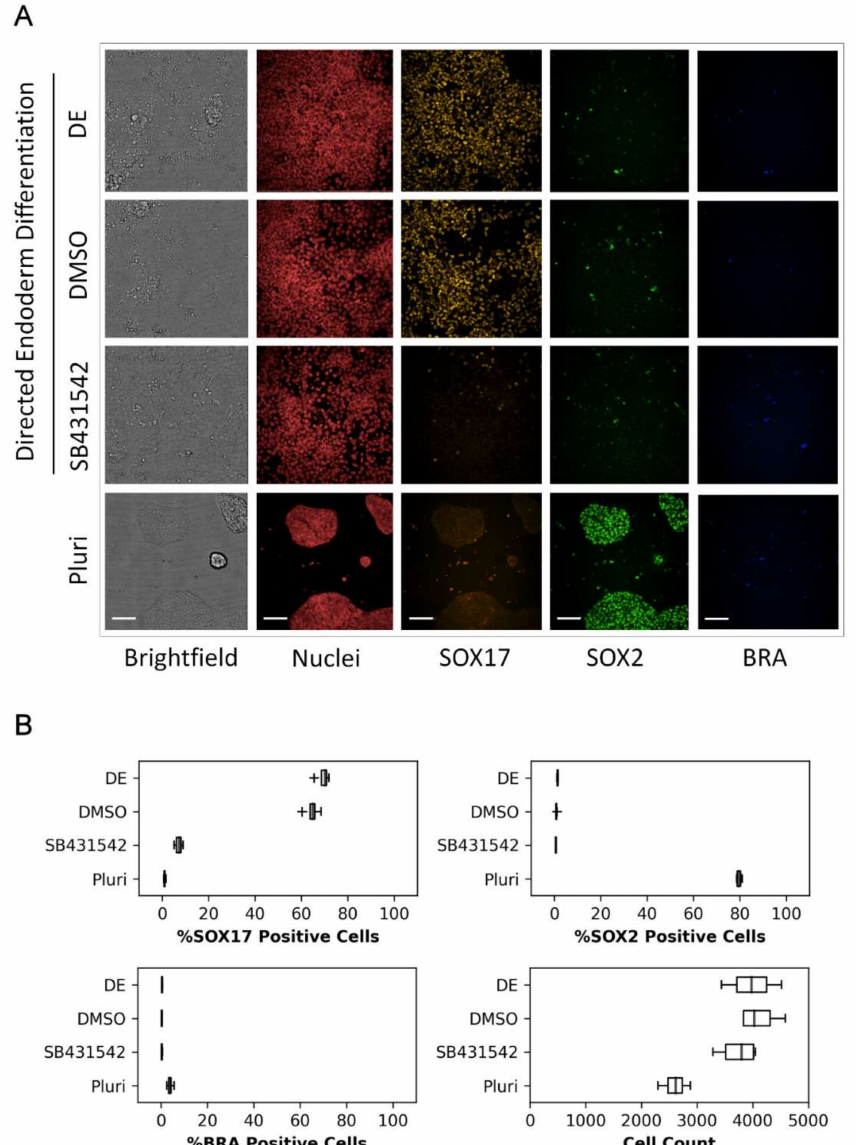
Figure 2. Representative RUES2-GLR biomarker expression images and data. RUES2-GLR cells represented across four conditions: directed endoderm (DE), directed endoderm with solvent control (DMSO), directed endoderm with TGF-ß receptor inhibitor control (SB431542), and pluripotent (Pluri). ( A ) Confocal images of cells displaying biomarkers SOX17 (yellow), SOX2 (green), BRA (blue), nuclear stain (red) and brightfield; 200 µ m scale bar. ( B ) Quantitative % responder and cell count data across the four conditions. Box and whisker plots: center line-median, box-first and third quartiles, whiskers-1.5*inter-quartile range, + outliers; ( n =